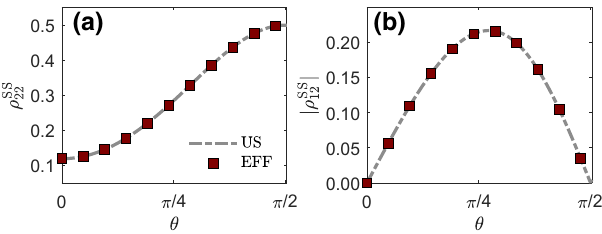
FIG. 5. The ultrastrong-coupling limit of the generalized spin- boson model in the steady state, presenting the (a) population and (b) coherence of the spin as a function of the angle θ , which controls the noncommutativity of operators. We note the exact agreement between the ultrastrong steady state [Eq. (45)] (US, light-gray dashed-dotted line) and our analytical results (maroon squares), calculated using Eq. (43). The parameters are the same as in Fig. 4, with λ → ∞